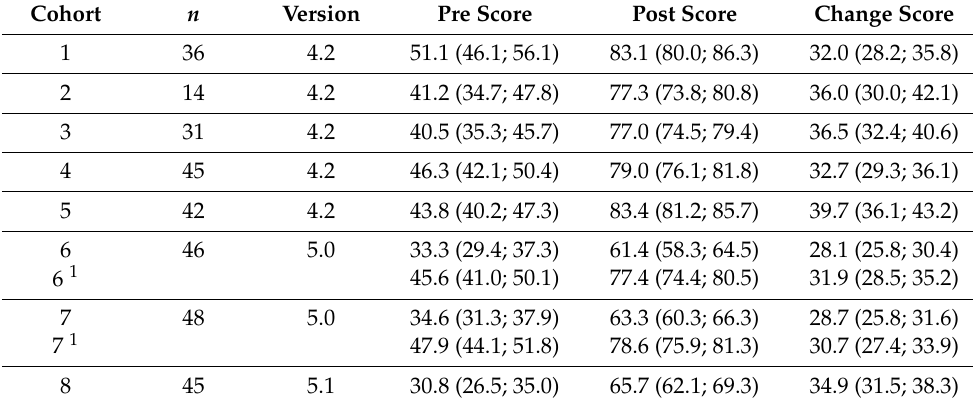
Table 1. WST-Q mean % scores (95% CI) by cohort.